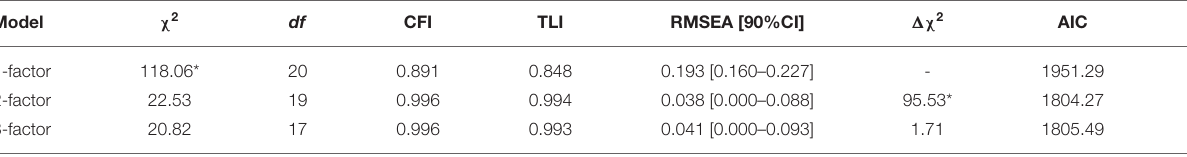
TABLE 1 | Goodness of fit and comparisons of all models.